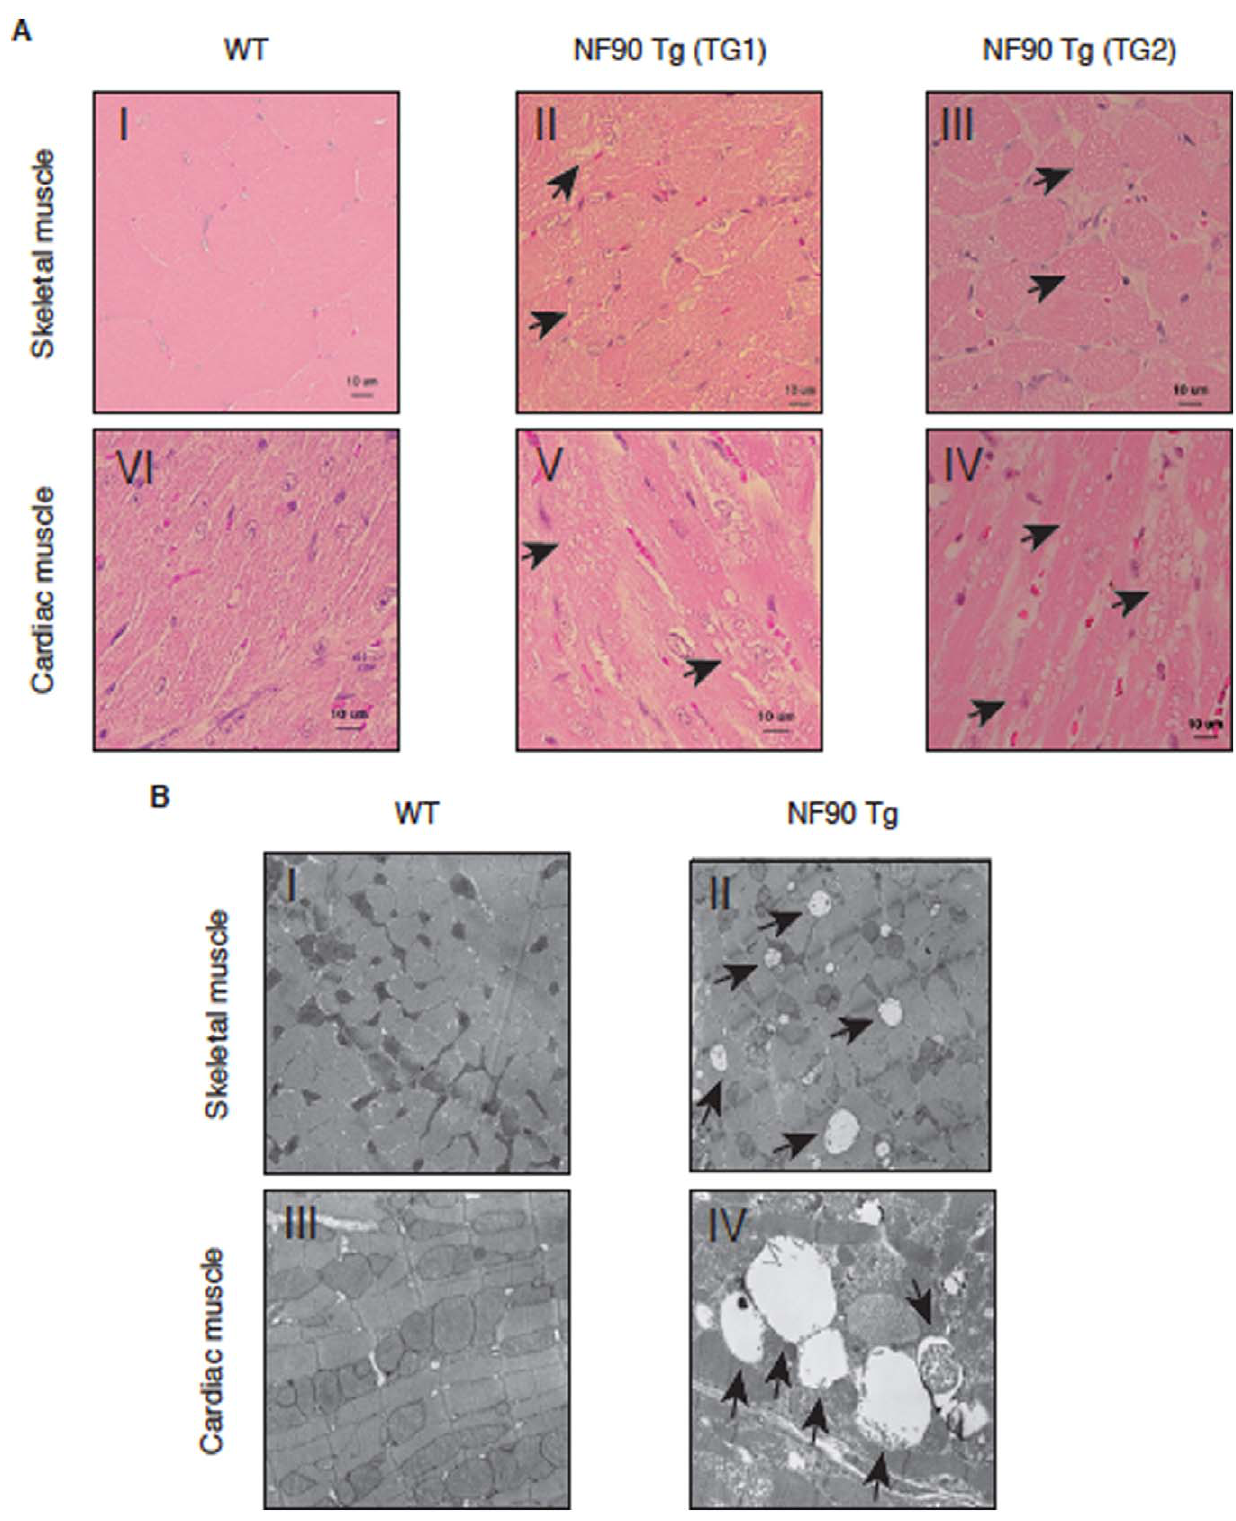
Figure 4. Skeletal and cardiac muscles of NF90 Tg mice exhibit mitochondrial degradation. (A) Haematoxylin and eosin (HE)-stained sections of skeletal (I to III) and cardiac (VI to IV) muscles from WT (I and VI) and NF90 Tg mice (line TG1: II and V, line TG2: III and IV) at 15 to 17 weeks of age. Arrows highlight vacuolations. Scale bars show 10 mm at the inset. (B) Transmission electron microscopy analysis of skeletal (I and II) and cardiac (III and IV) muscles from WT (I and III) and NF90 Tg mice (II: line TG2, IV: line TG1) at 13 to 17 weeks of age. Arrows indicate degenerating mitochondria.